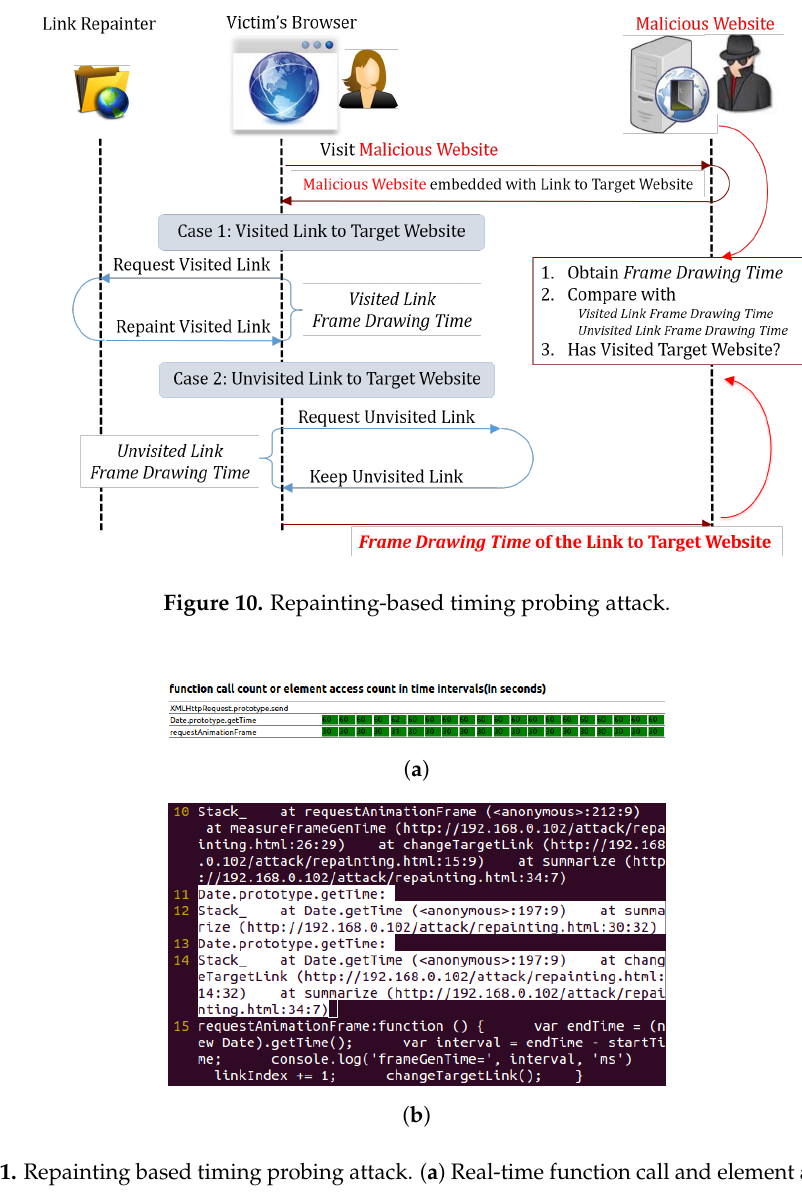
Figure 11. Repainting based timing probing attack. ( a ) Real-time function call and element access chart; ( b ) behavior log (attack pattern is